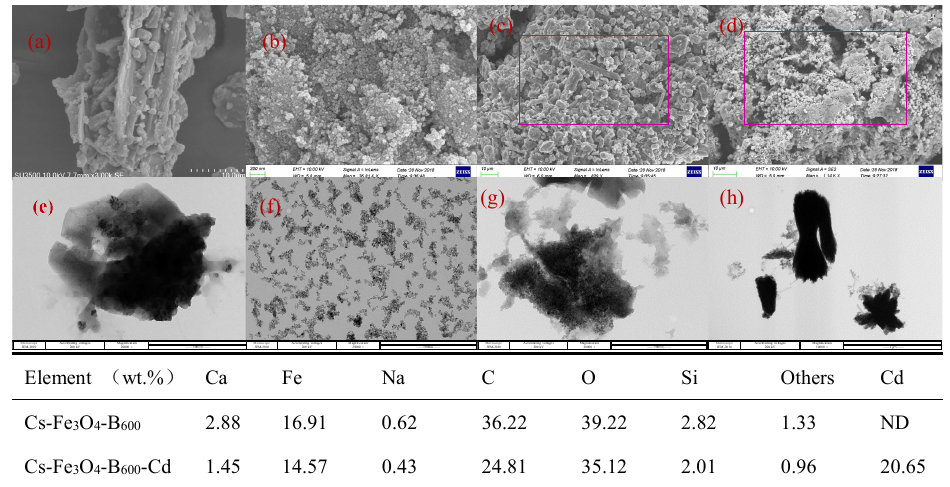
Figure 6. SEM and TEM images of B 600 ( a , e ), Fe 3 O 4 ( b , f ), Cs-Fe 3 O 4 -B 600 ( c , g ), and Cs-Fe 3 O 4 -B 600 -Cd ( d , h ). Note: the table shows the element compositions of Cs-Fe 3 O 4 -B 600 ( c ) and Cs-Fe 3 O 4 -B 600 -Cd ( d ).